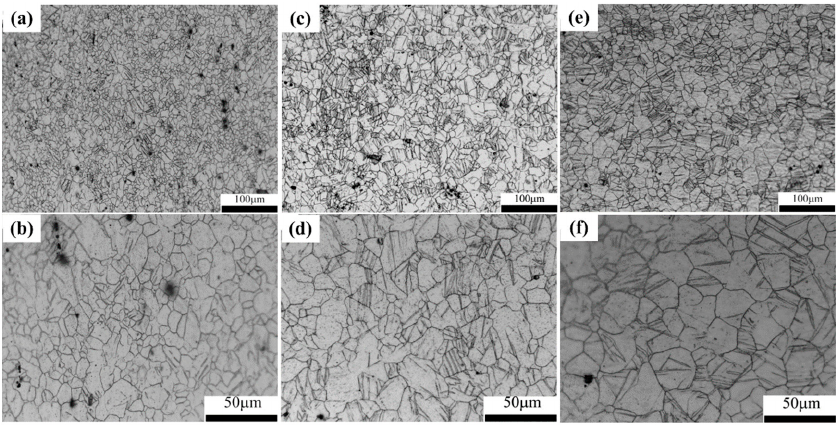
Figure 3. Microstructures of the ECAR-CB AZ31 Mg alloy samples prepared at different final rolling temperatures: ( a , b ) 350 °C, ( c , d ) 450 °C and ( e , f ) 550 °C. temperatures: ( a , b ) 350 ◦ C, ( c , d ) 450 ◦ C and ( e , f ) 550 ◦